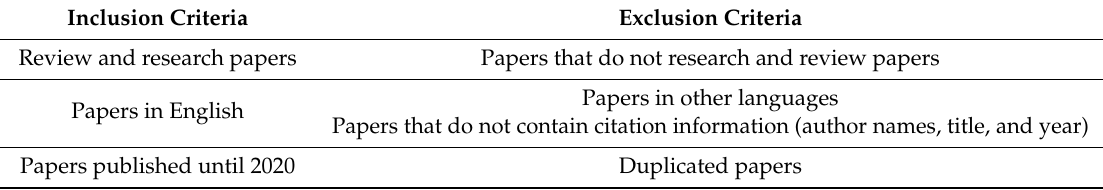
Table 2. Inclusion and exclusion criteria employed in the triage stage of the method adopted.